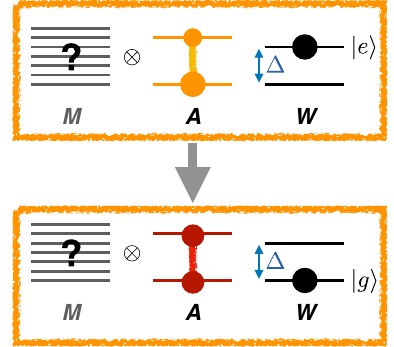
FIG. 3. Example work cost if correlations between M and A are allowed to build up. Since M is locally exactly preserved, it can be reused on further states (just not on those ones on which it has already acted before). This transition is possible at a work cost of T (about 1 = 3 less than in Fig. 2), even though the only Δ ⪆ 0 . 26 k B catalyst M consists only of a single